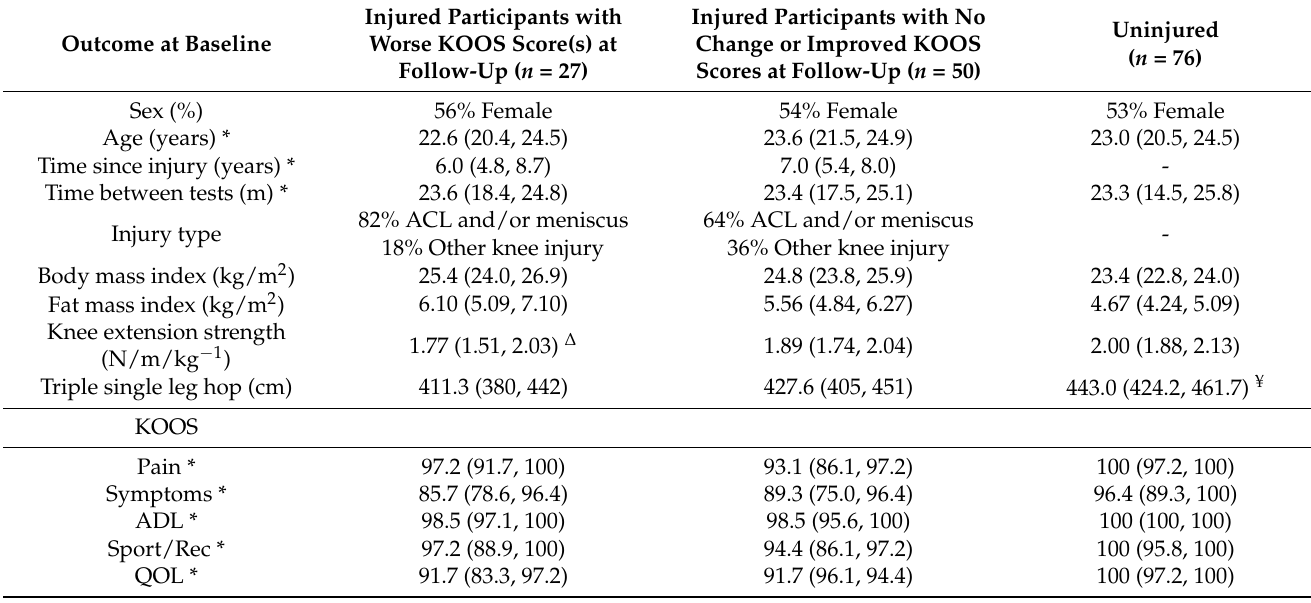
Table 4. Baseline clinical features for injured participants who had worse KOOS scores at follow-up (at least one KOOS subscale worse than the minimal detectable change) and other injured and uninjured participants using mean (95% confidence interval (CI)) or median (25th, 75th